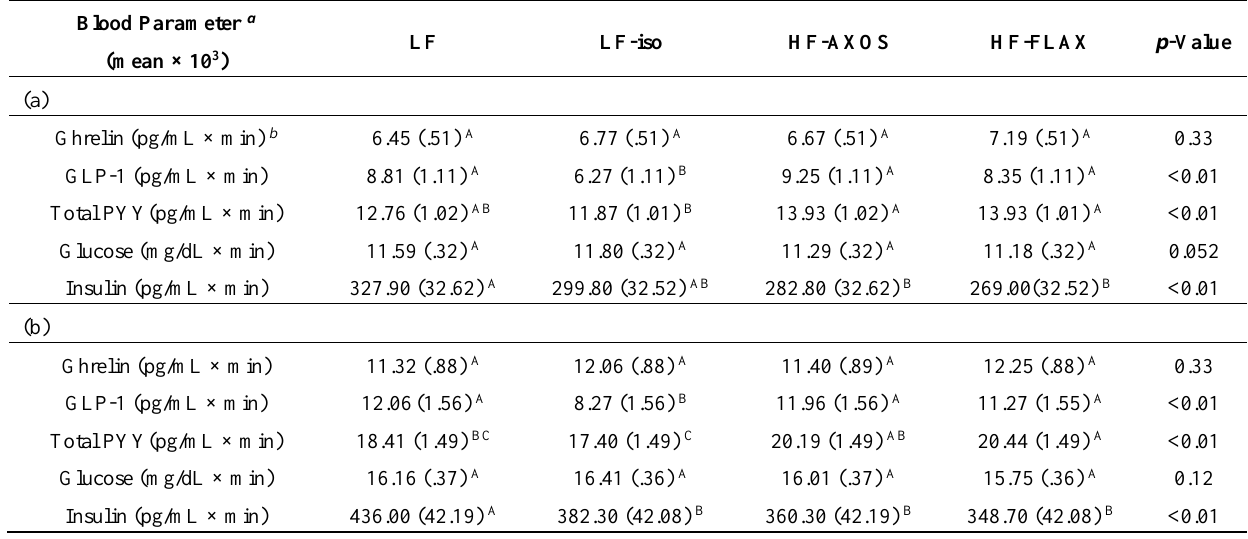
Table 4. Net incremental area under the curve (niAUC) for each hormone at 2 h and at 4 h: (a) 2 h niAUC, (b) 4 h